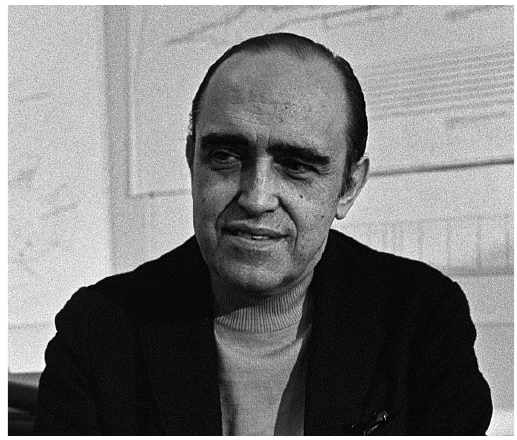
Figure 2. Adapted